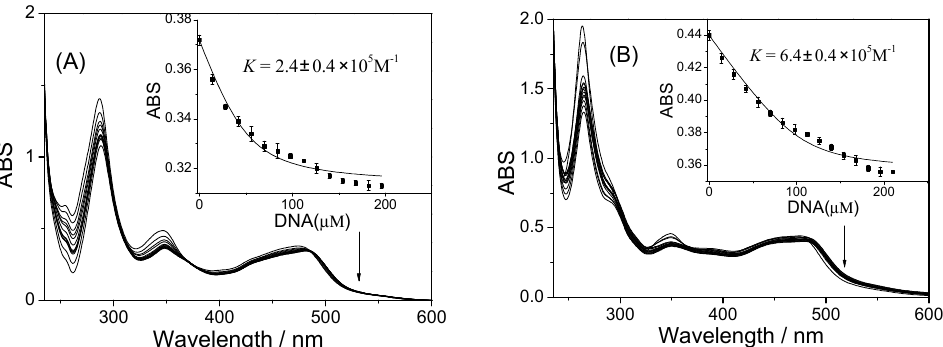
Figure 1. Absorption spectra of 1 ( A ) and 2 ( B ) (20 µ M) after titrating different amounts of CT-DNA. Inset: plots of ε a vs. [DNA].